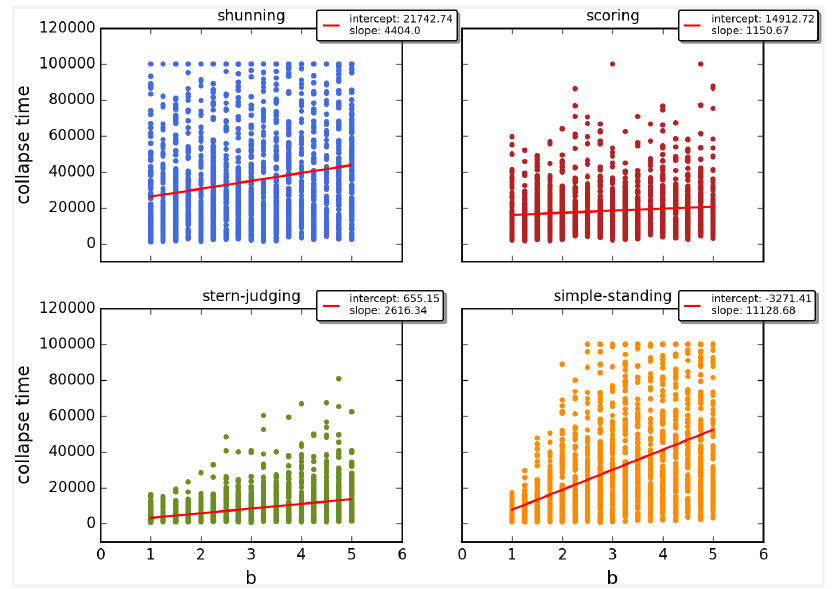
Fig 1. The time elapsed till the collapse of cooperation, MST80. The figure shows the average time until the collapse of cooperation as a function of the value of the benefit ( b ) for different social norms in the first scenario (MST80). Each symbol represents the collapse time of a single run; parameters are as follows: n = 100, c = 1, α = 1, β = 4, MST = 80%. Colour code: (a) shunning: blue; (b) scoring: red; (c) stern-judging: green; (d) simple-standing: orange. Regression lines were fitted to visualize the relationship between collapse times and b .